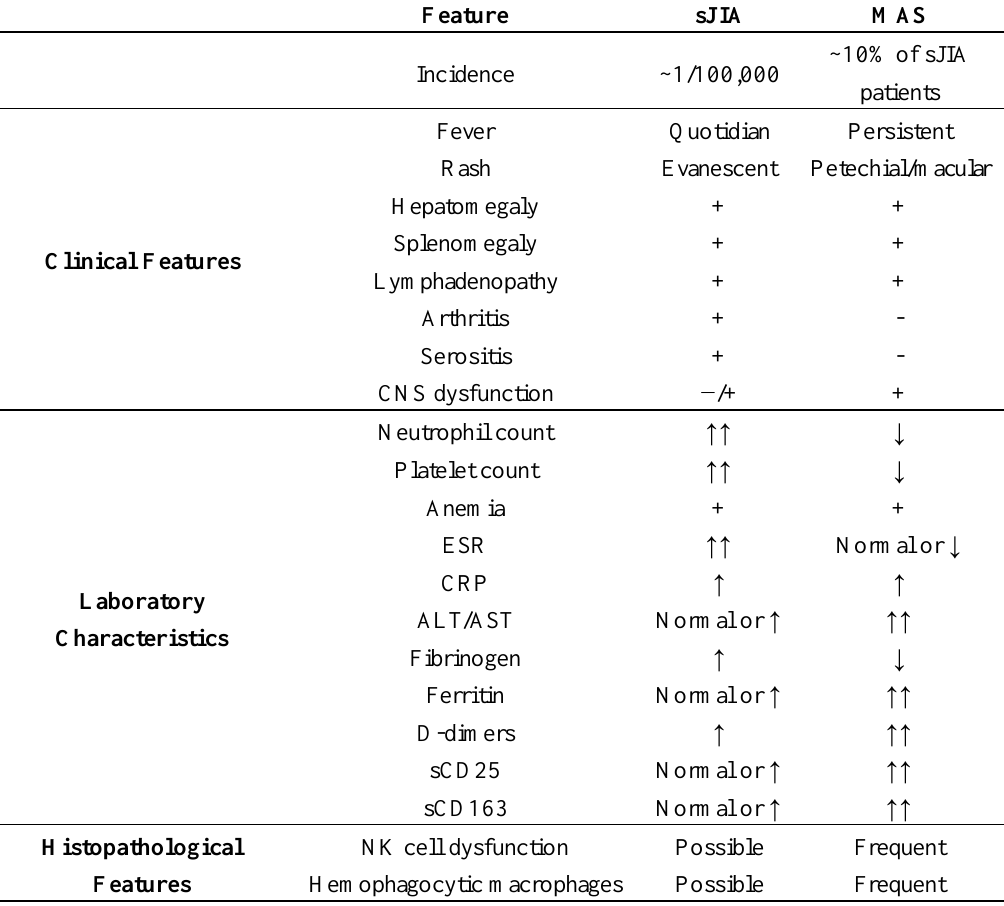
Table 2. Symptoms of sJIA and MAS in association with sJIA